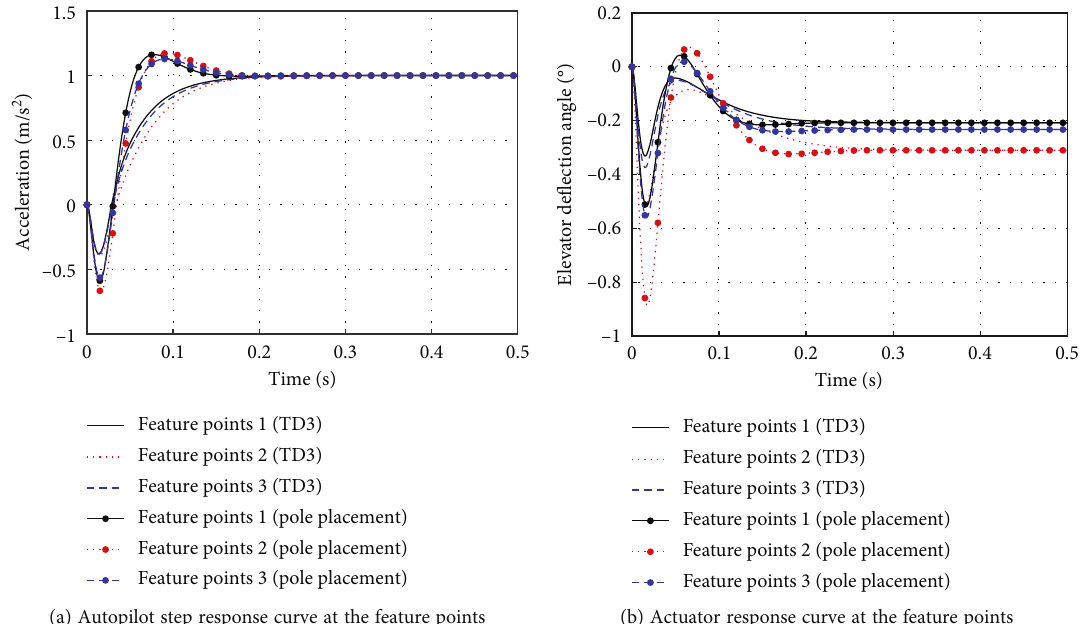
Figure 10: Step response curves at the feature